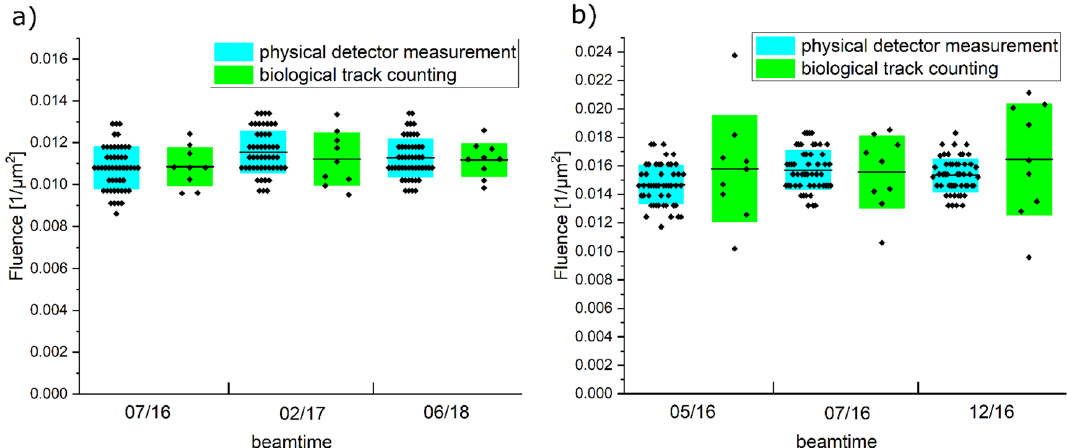
Figure 3. Comparison of the fluence measurements for ( a ) lithium ions and ( b ) Carbon ions for each beamtime. The physical detector measurements are shown in cyan and green the biological track counting. No statistically significant difference between the measurements for each ion could be